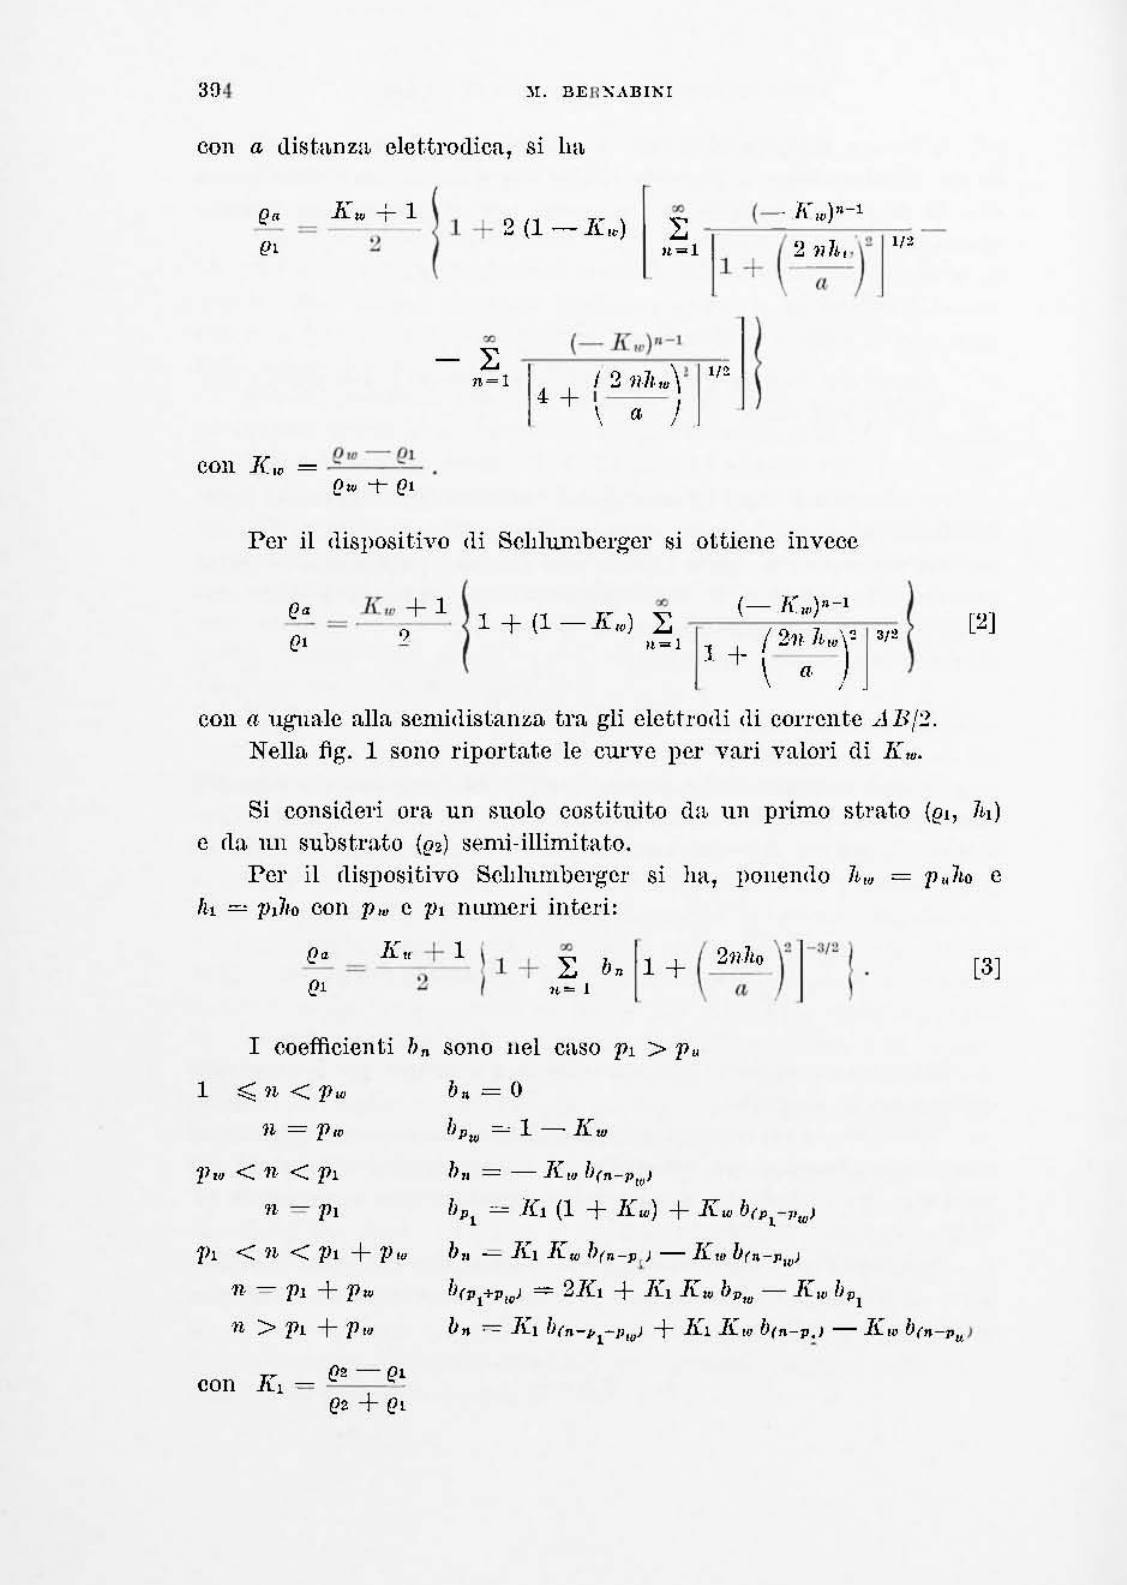
Nella fig. 1 sono riportatc lc curvc pcr vari valori di K,c.